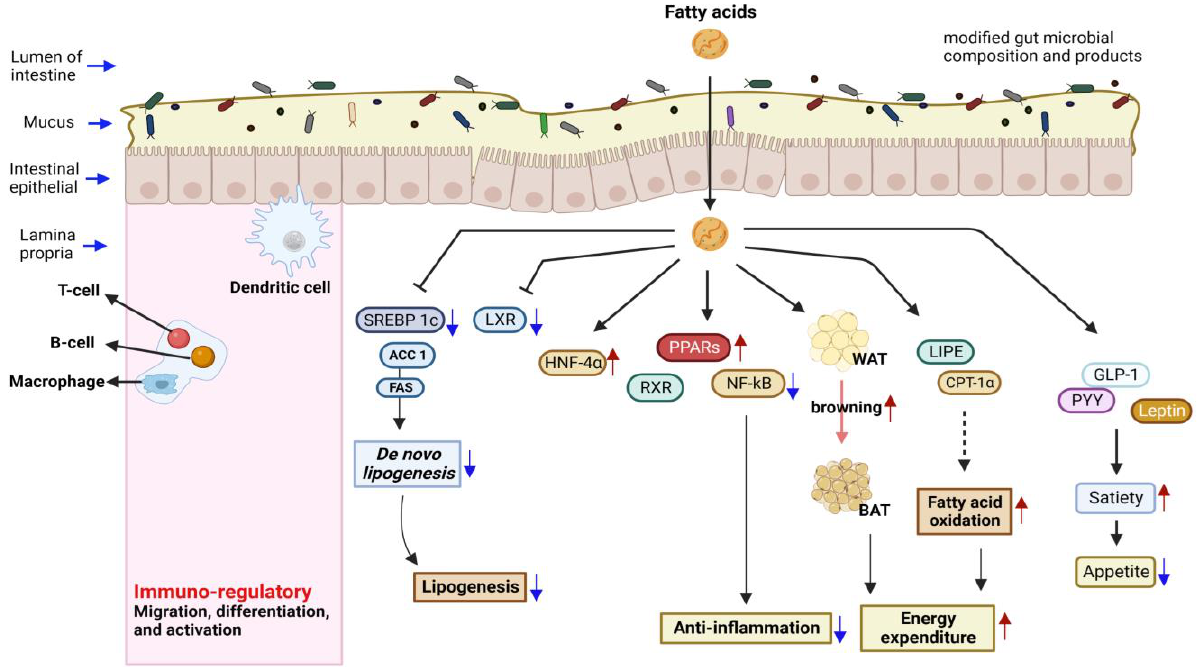
Figure 2. Fatty acids regulate many health-promoting pathways and innate immune responses. They regulate gene transcription via changes in the activity or abundance of nuclear receptors.